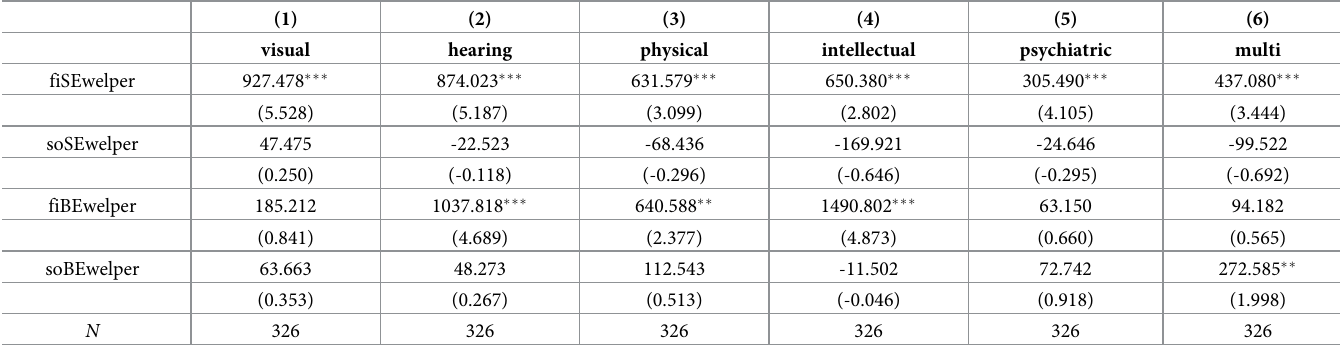
Table 9. The results of welfare expenditures on subtypes of RSE